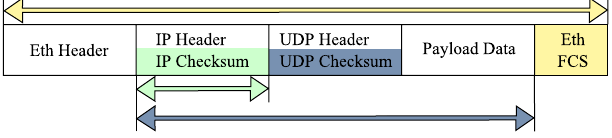
FIG. 8. Checksum coverage in a UDP/IP